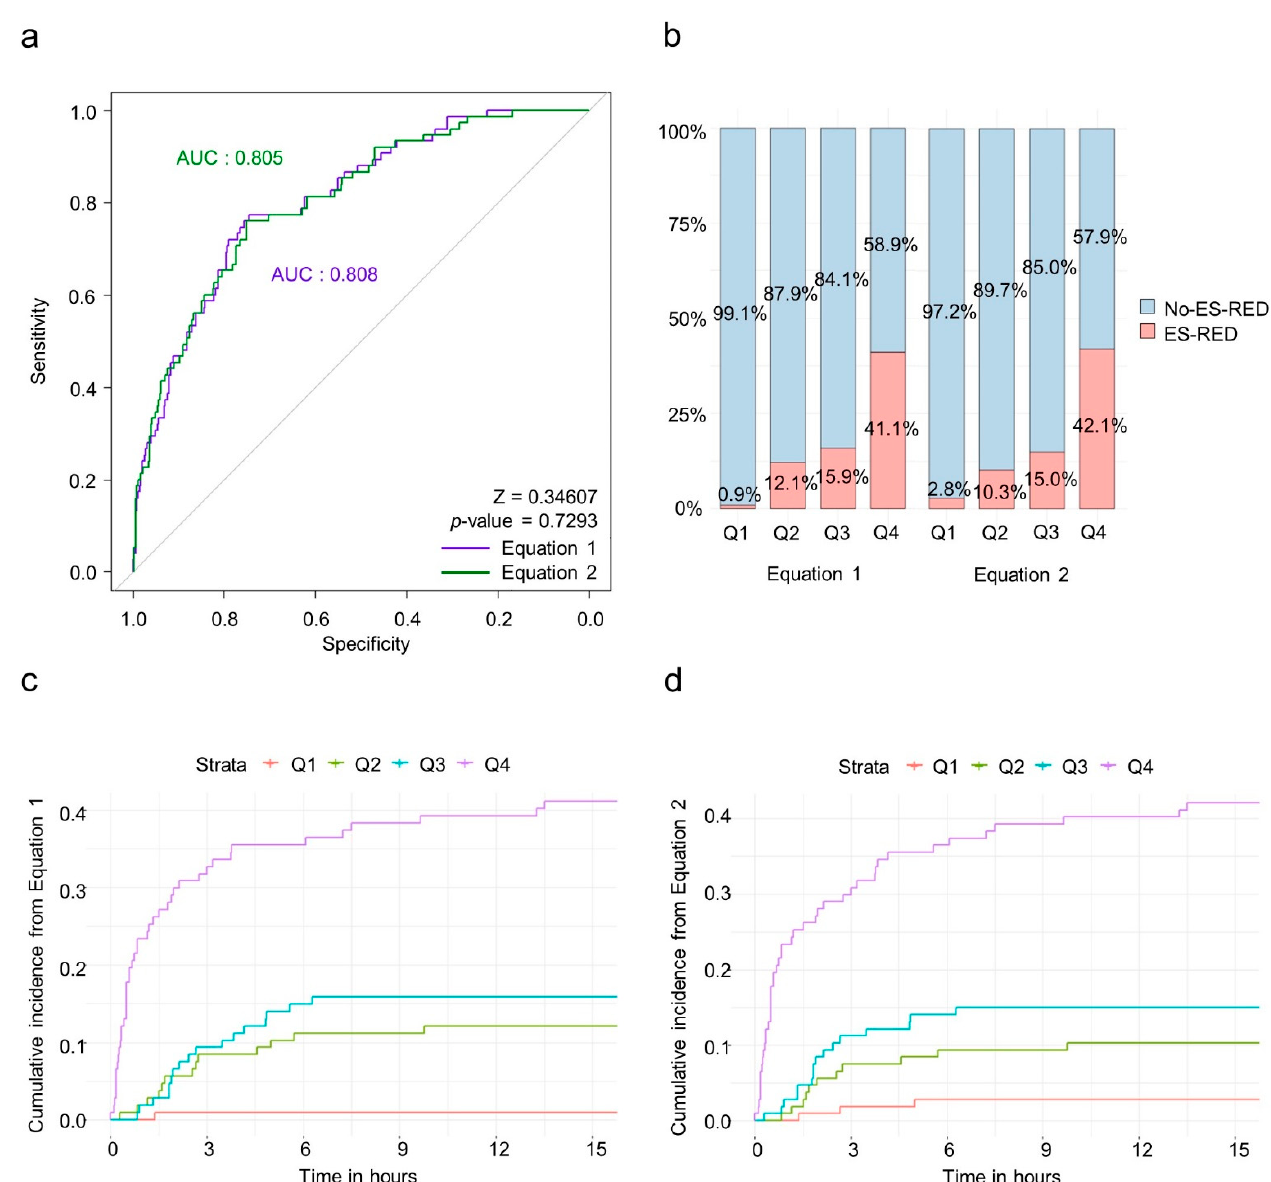
Figure 1. Predictive performance of equations in the derivation cohort. ( a ) Receiver operating characteristic (ROC) curve analysis of both equations. ( b ) Frequency of early seizure recurrence in the emergency department (ES-RED) by quartiles in both Equations. ( c ) Cumulative incidence of ES-RED over time by quartiles in Equation (1). ( d ) Cumulative incidence of ES-RED over time.